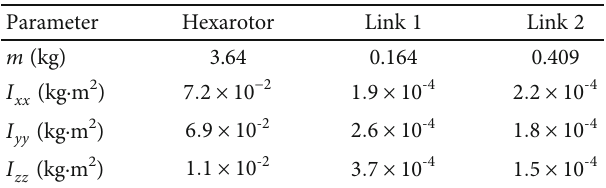
Figure 9: Structure of the equipment platform. Table 1: Aerial robot parameters.